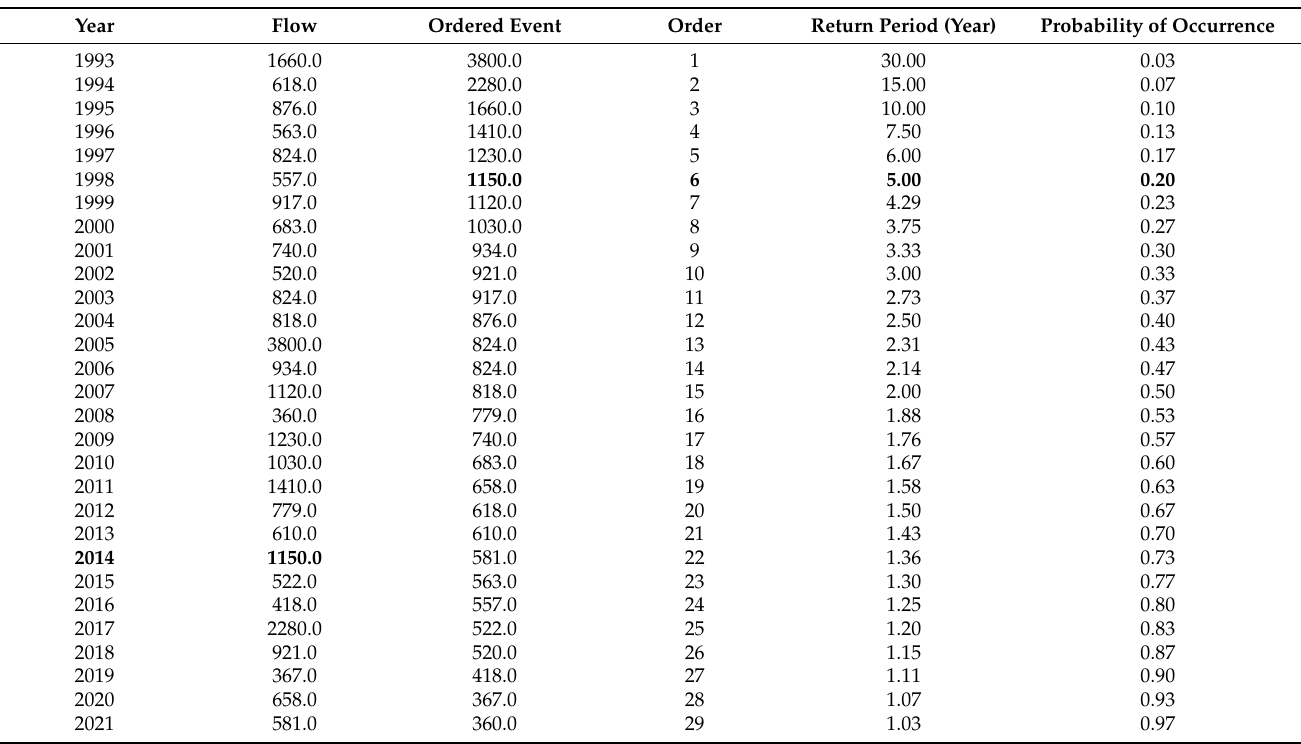
Table A2. Frequency analysis. Historical flow data in m 3 /s for the proposed example